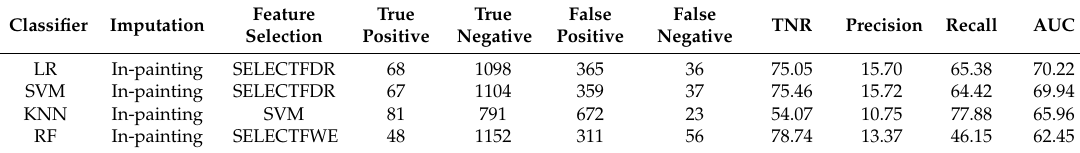
Table 1. Details of classification results with the highest AUC in each model.